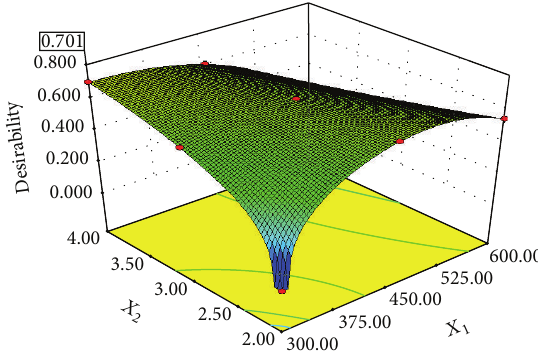
Figure 9: Effect of drying temperature and frying time on 3D plot of the desirability index for the optimal frying